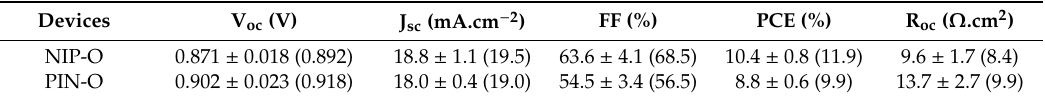
Table 1. J–V results (averages) measured in reverse scan mode with an illuminated area of 0.131 cm 2 for NIP- and PIN-type opaque perovskite solar cells (PSCs) (the values in brackets are the J–V performance of the champion cells). J–V results are given for campaigns of about twenty cells in total for each architecture. (R oc is the equivalent resistance determined at V oc